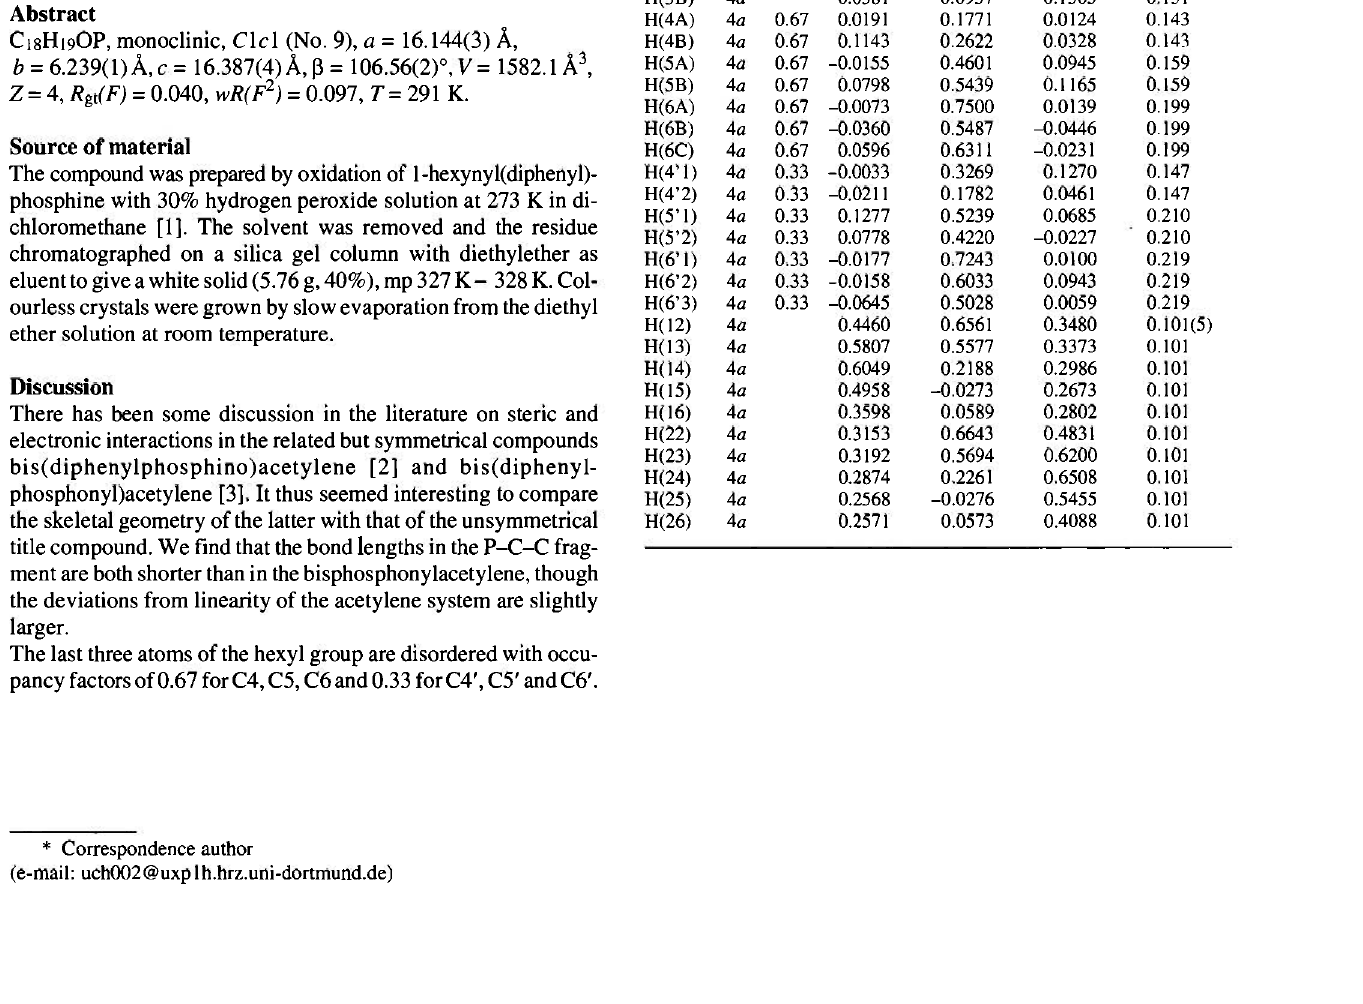
Table 2. Atomic coordinates and displacement parameters (in A